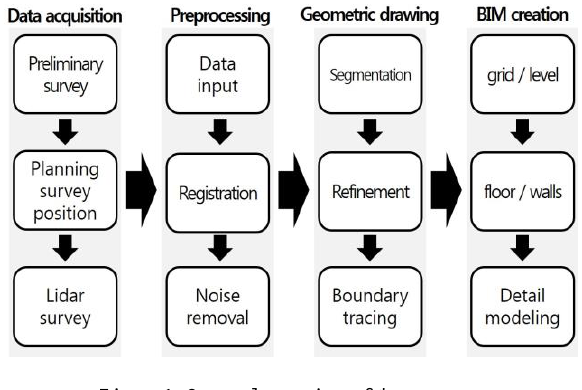
Figure 1. General overview of the